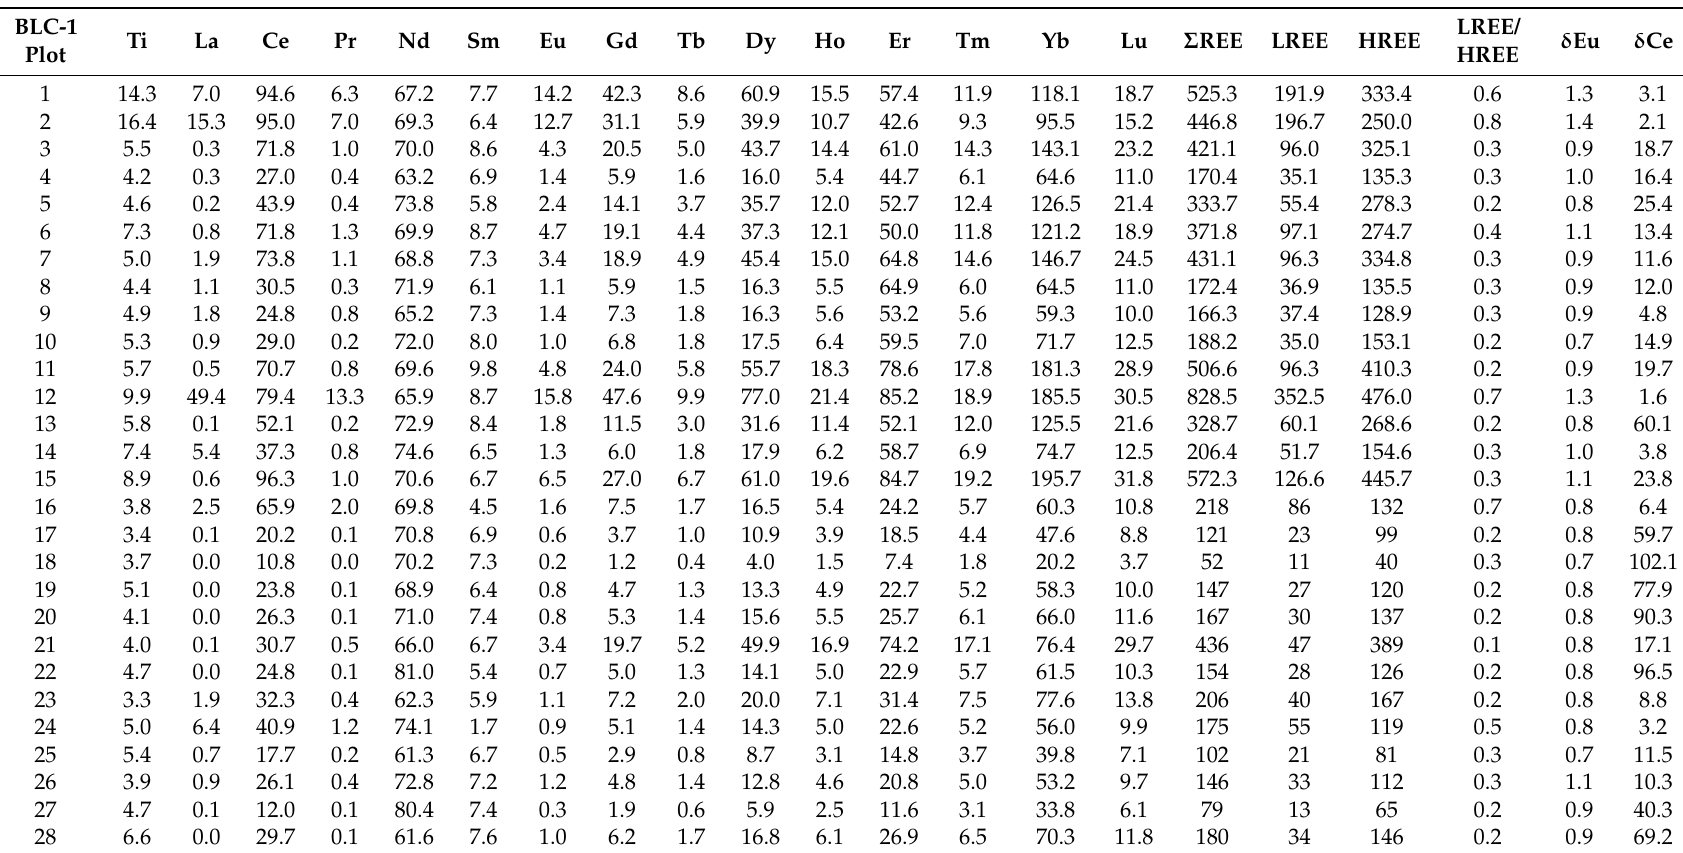
Table 3. Zircon trace elements for samplesBLC-1 and BLC-2 ( µ